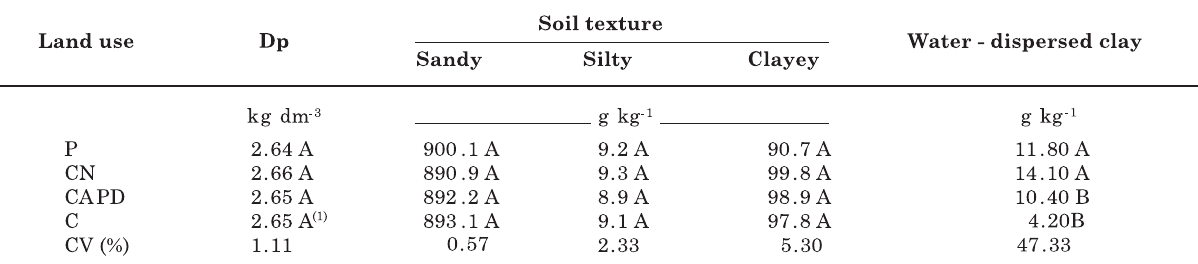
Table 1. Mean values for particle density (Pd) and dystrophic Red Latosol texture of the three composite samples taken from the 0–20 cm soil layer, based on 20 simple samples for each land use profile